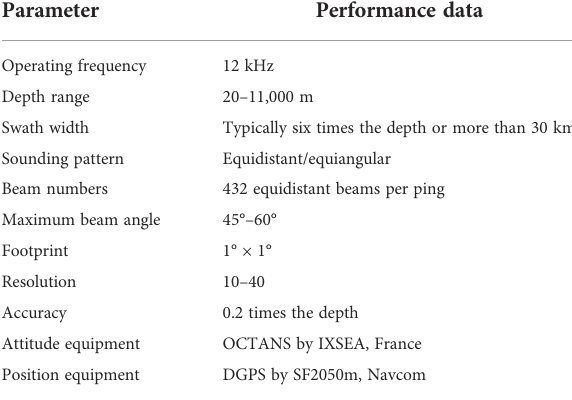
TABLE 1 Instruments and parameters for seabed